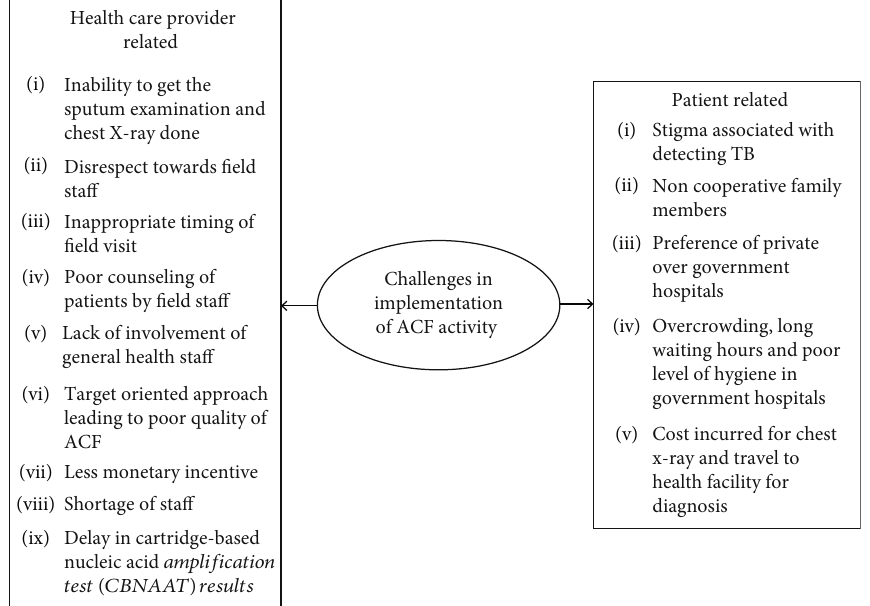
Figure 3: Challenges in implementation of ACF